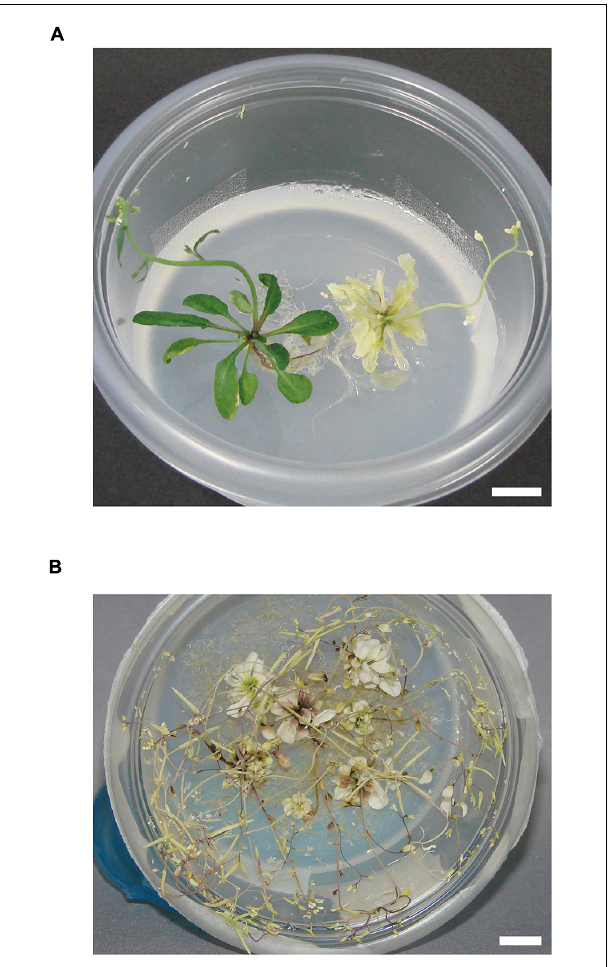
FIGURE 2 | Phenotype of homozygous ppi2-2 plants grown in Ziploc ® containers. (A) Representative phenotype of wild-type (left) and ppi2-2 (right) plants grown in Ziploc ® containers. After transferring the plants from plates, they were grown in a Ziploc ® container for 10 days. Bar = approximately 1 cm. (B) At a later stage, the ppi2-2 plants set seeds in the Ziploc ® container. Bar = approximately 1